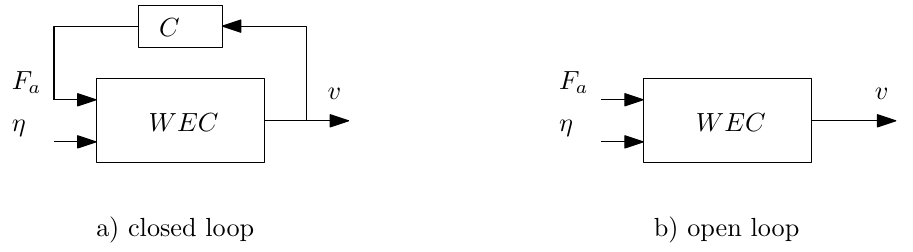
Figure 1. Closed loop layout ( a ) compared to open loop layout ( b